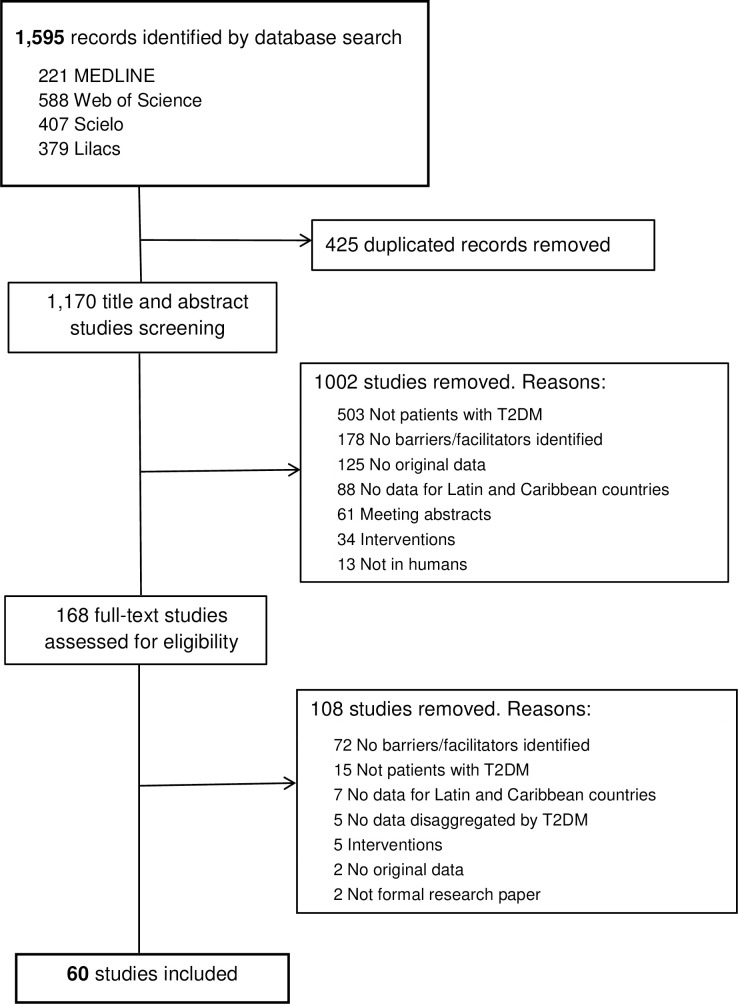
PRISMA flow diagram.